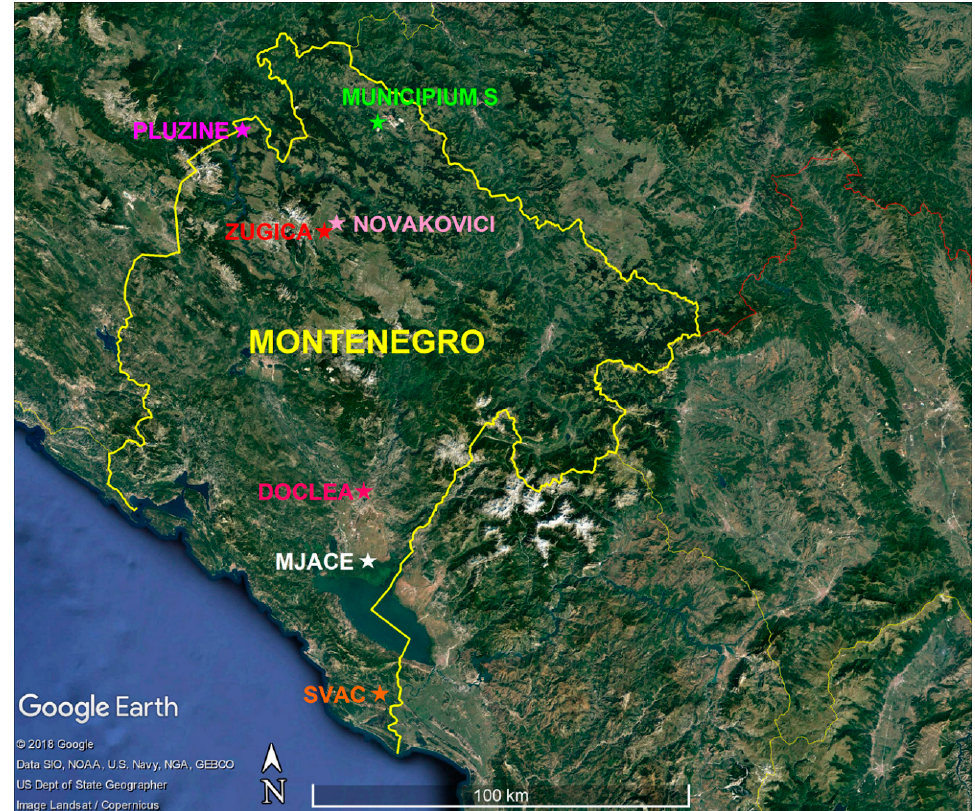
Figure 1. Location of study areas on a Google Earth TM satellite image (2018).